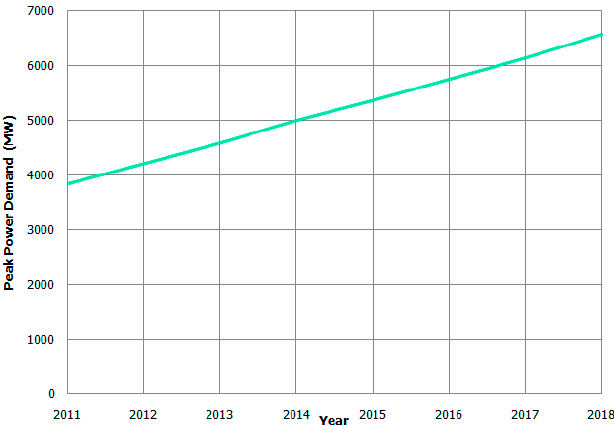
Figure 3. Oman peak power demand for 2011–2015 and projection until 2018.